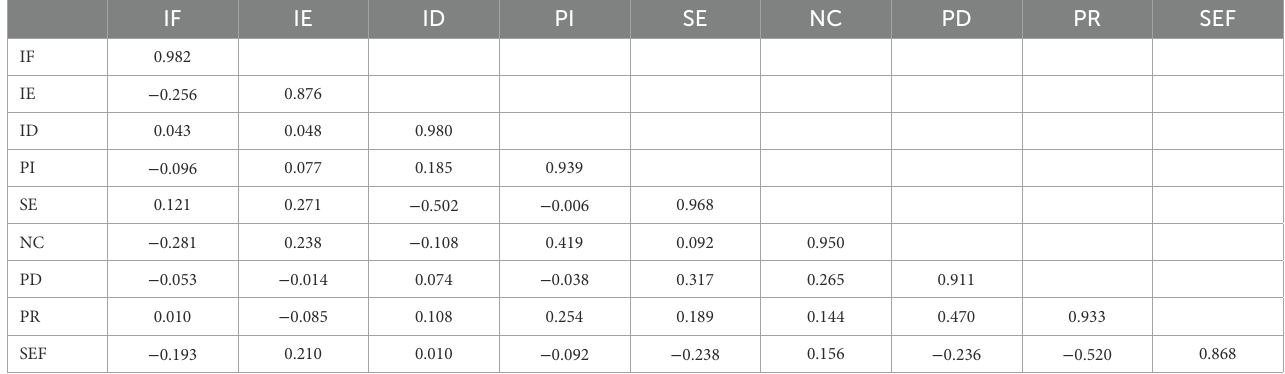
TABLE 11 Results of discrimination validity